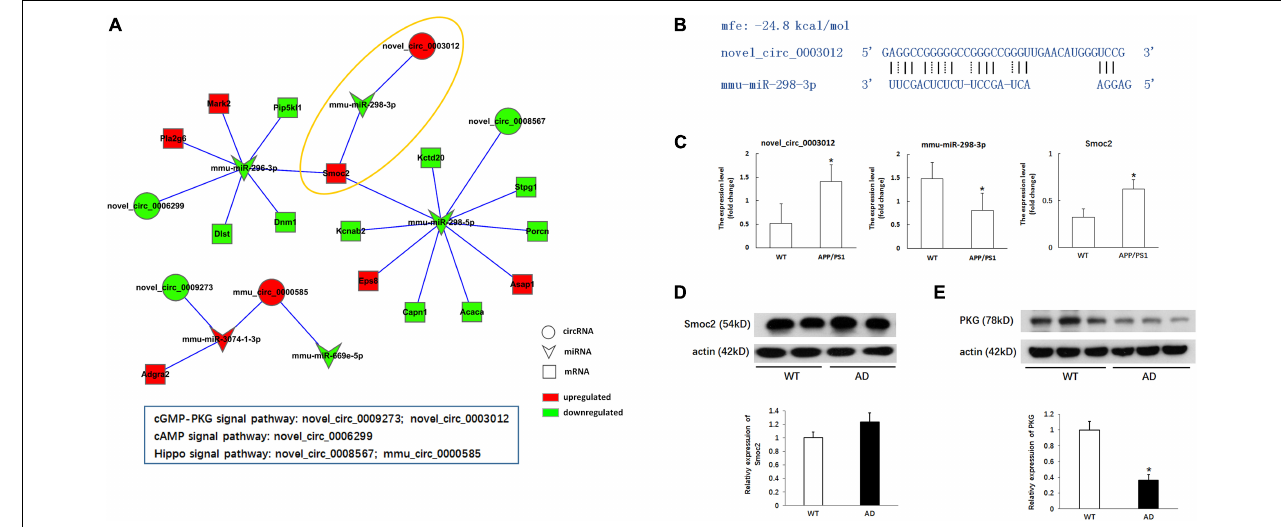
FIGURE 5 | Verification of the potential regulation mechanism of circRNAs in the key signaling pathways. (A) CircRNA-ceRNA network of circRNAs in the key signaling pathways. Circle nodes represent circRNAs, triangle nodes represent miRNAs, and rectangle nodes represent mRNAs. Red represent upregulated, green represent downregulated. (B) The interaction of novel_circ_0003012/mmu-miR-298-3p. (C) The expression levels of novel_circ_0003012, mmu-miR-298-3p and SMOC2 by qPCR in hippocampal tissues of 8-month-old APP/PS1 mice and WT mice. CircRNA and mRNA expression was quantified relative to Gapdh expression level by using the comparative cycle threshold ( (cid:49) CT) method. MiRNA expression was quantified relative to U6 expression level by using the comparative cycle threshold ( (cid:49) CT) method. Data are presented as means ± SD ( n = 6; * p < 0.05). (D) The expression of Smoc2 by Western blot in hippocampal tissues of 8-month-old APP/PS1 mice and WT mice. Data are presented as means ± SD ( n = 2). (E) The expression of PKG by Western blot in hippocampal tissues of 8-month-old APP/PS1 mice and WT mice. Data are presented as means ± SD ( n = 3; * p < 0.05).